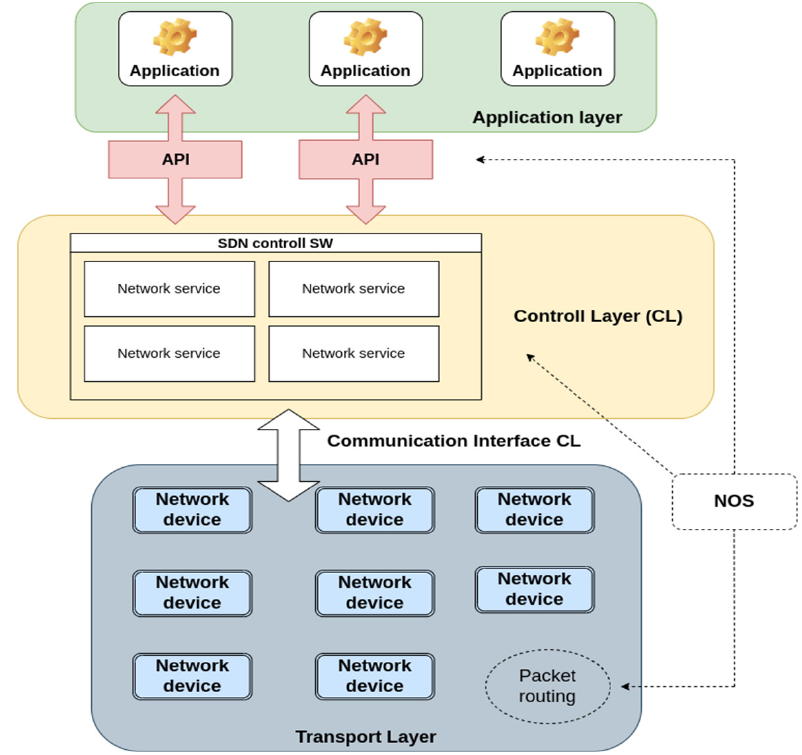
Figure 1. Architecture of SDNs.